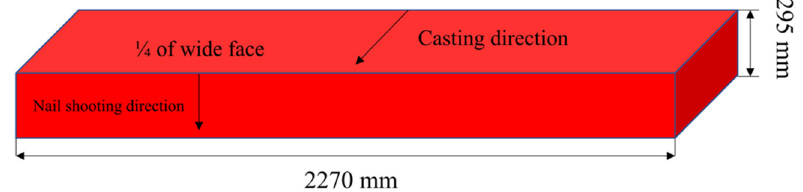
Figure 3. Nail shooting position.